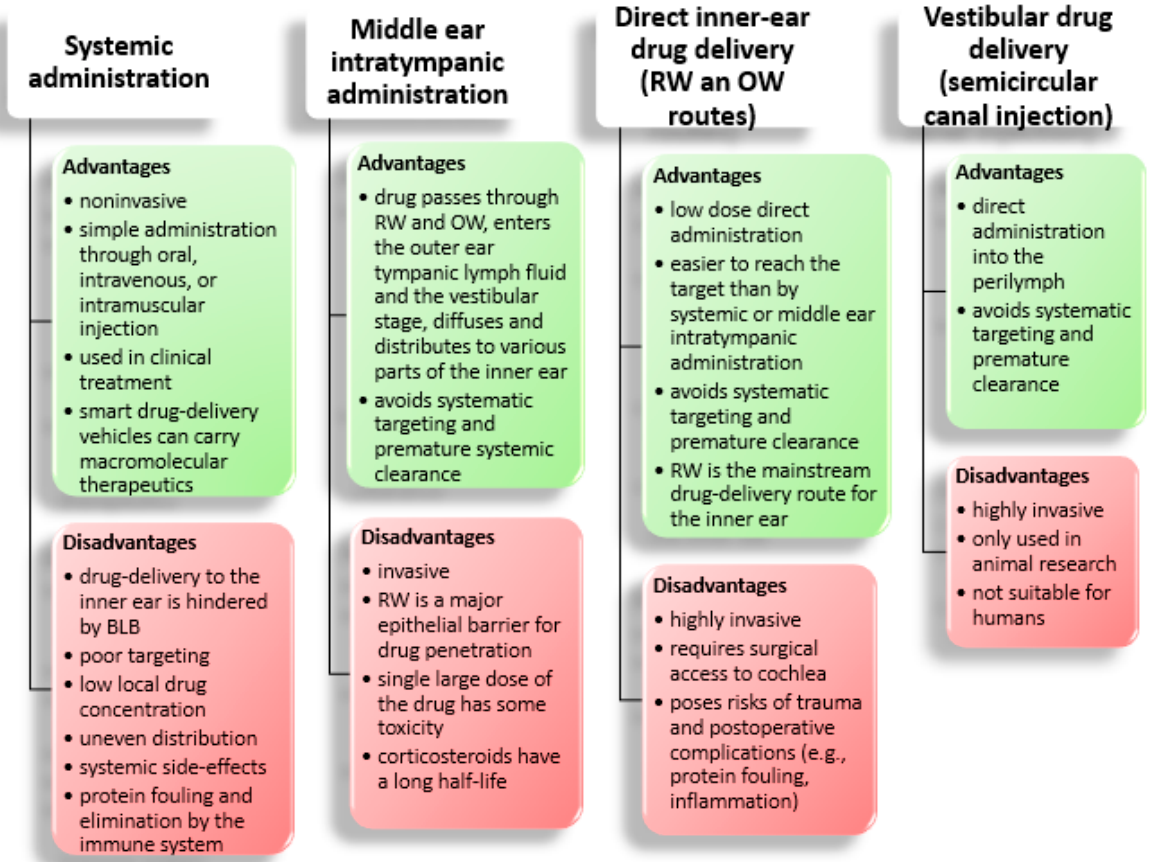
Figure 3. Comparison of different inner ear administration routes. Abbreviations: BLB—blood-labyrinth barrier, RW—round window, OW—oval window. Created based on information from literature references [14,51,54,56,75].